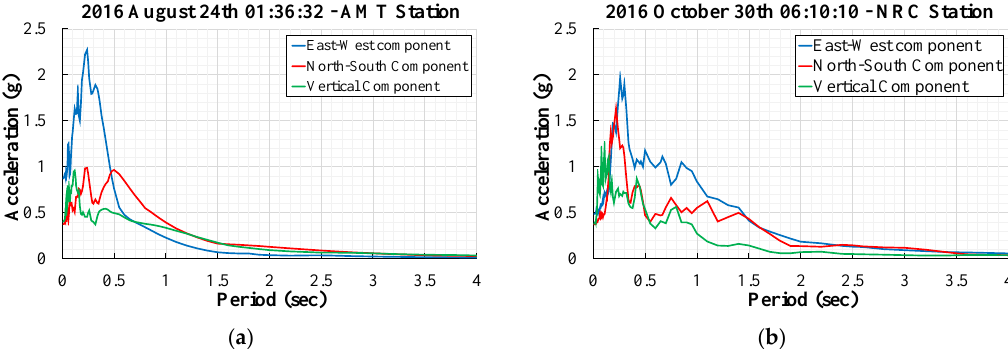
Figure 14. Acceleration response spectra for the 24 August ( a ) and 30 October ( b ) main shocks [80].